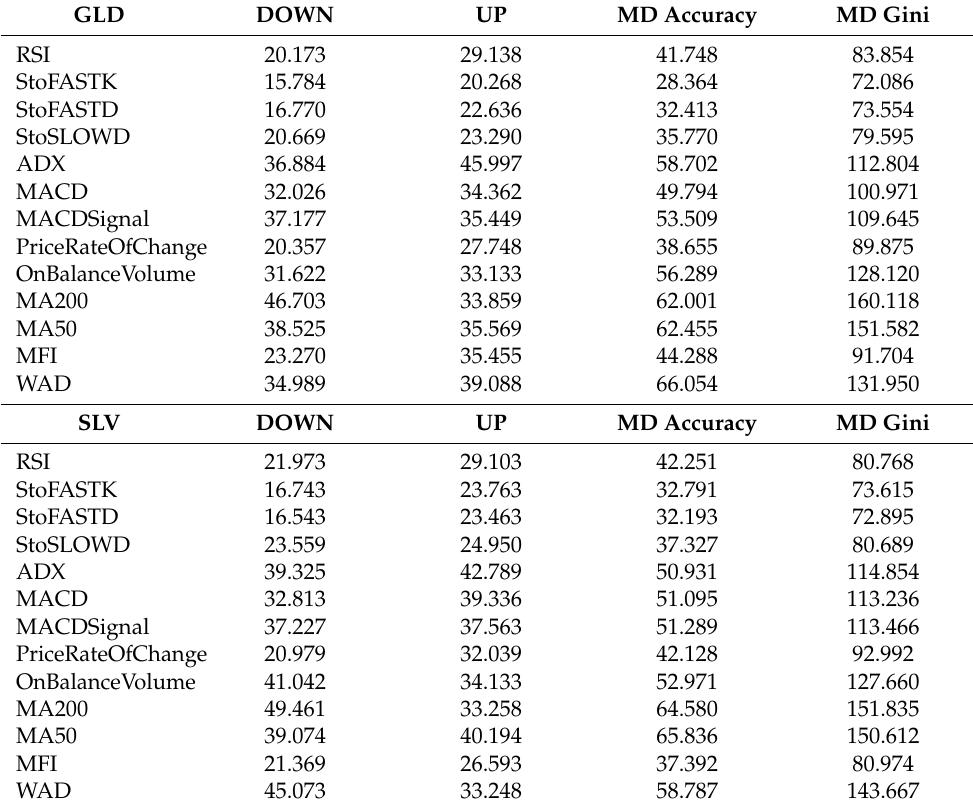
Table 2. Variable importance for predicting GLD and SLV price